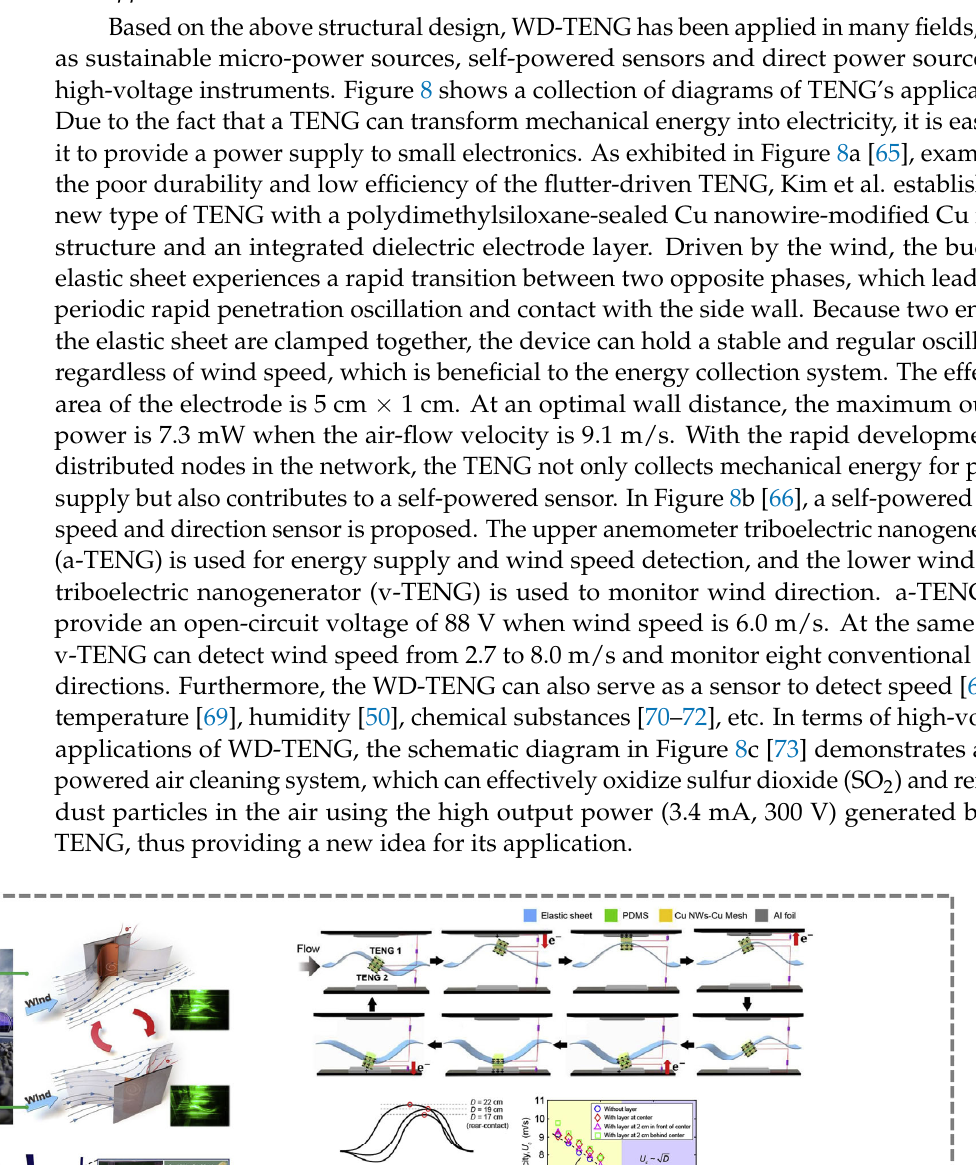
Figure 8. Applications enabled by WD ‐ TENG: ( a ) wind energy collection network based on TENGs (reproduced with permission [65]. Copyright 2019, Nano Energy ). ( b ) Self ‐ powered sensor system for detecting wind speed and direction (reproduced with permission [66]. Copyright 2018, ACS Nano ). ( c ) Self ‐ powered air purification system (reproduced with permission [73]. Copyright 2015, Nano Energy ). 4. Summary and Perspective Wind energy is one of the most common energy sources in nature, with unique at ‐ tributes such as its green, safe and recyclable characteristics. TENG is an emerging renew ‐ able energy technology that can convert wind energy into electrical energy. In this review, we systematically summarized the latest developments in WD ‐ TENG considering struc ‐ tural design, output performance and practical applications. Benefiting from their low cost, easy manufacture, and effective work at low frequencies, various wind energy ‐ based devices have been designed. Some common structures are flutter ‐ based structures, rotat ‐ ing structures and bionic structures. Moreover, WD ‐ TENG can be combined with SC and EMG to broaden its application fields. On the one hand, WD ‐ TENG can be used as a